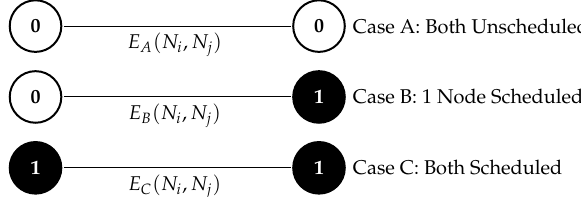
Figure 1. The number of possible cases when a single edge exists between two nodes in the conflict graph. The scheduled and unscheduled nodes have states arbitrary nodes, and E A ( N i , N j ) , E B ( N i , N j ) , and E C ( N i , N j ) represent edges in each